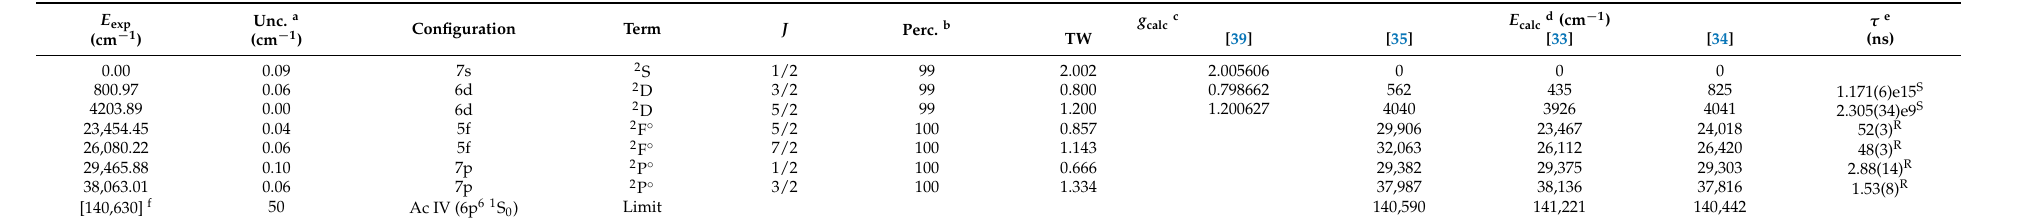
Table 8. Energy levels of Ac